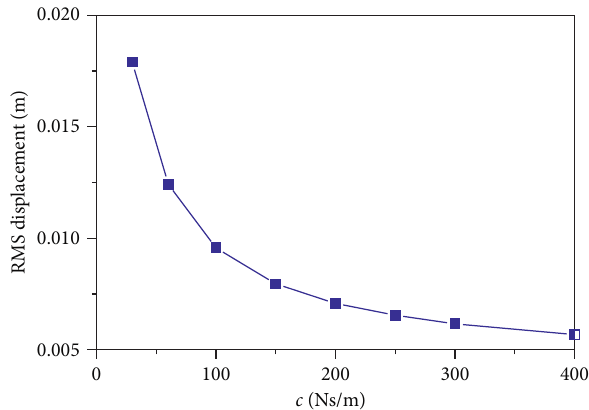
Figure 11: The relationship between the root mean square of structural displacement response and the viscosity coefficient of damper.